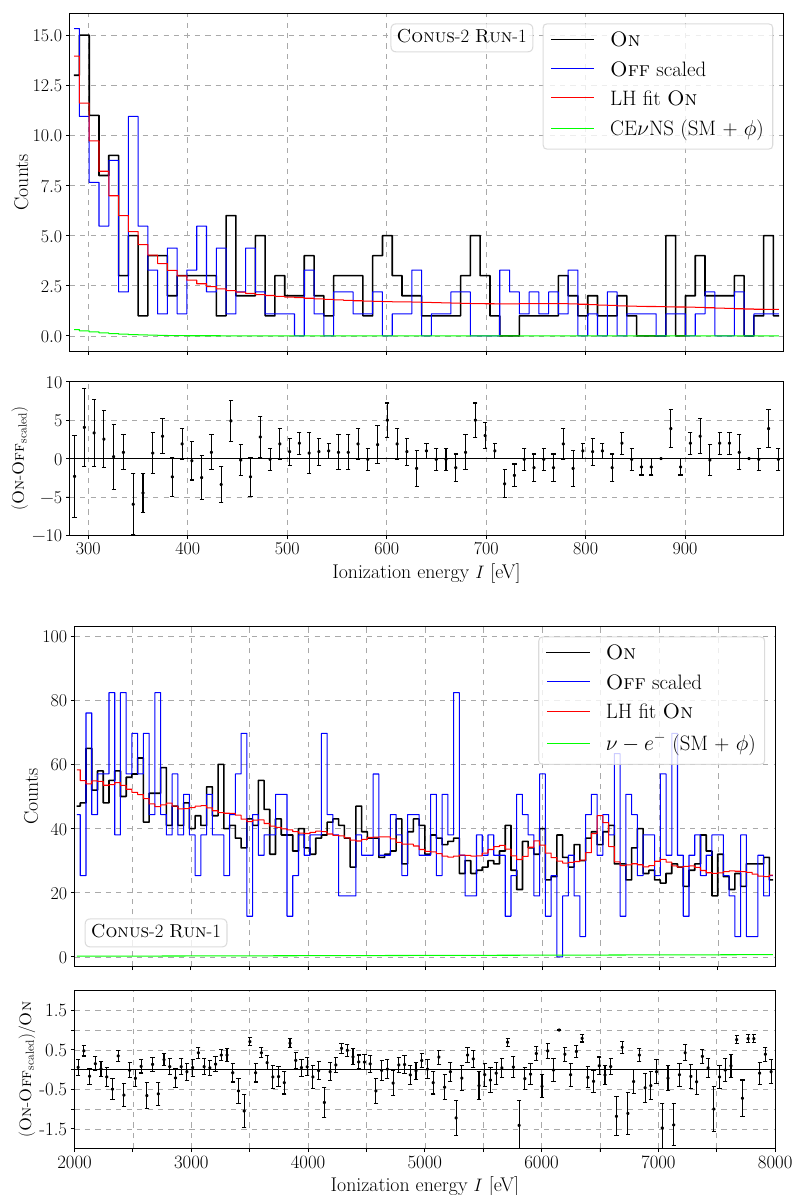
Figure 2 . Exemplary fits to experimental data in the case of a simplified light scalar mediator, cf. section 3.2.2. A combined fit to all data sets of table 2 is performed and collected reactor On data (black), the scaled reactor Off data (blue) as well as the obtained likelihood fit (red) are illustrated for detector C2 and a quenching parameter of k = 0 . 16 , assuming free coupling and mediator mass of the underlying BSM model. The received signal events (SM + BSM contribution) are indicated in green. Top: fit of the modified CE ν NS signal in the ROI below 1 keV ee . To illustrate the agreement between the collected reactor On and reactor Off periods, we show the corresponding residuals in total events beneath. Bottom: fit of modified neutrino-electron scattering in the ROI between 2 and 8 keV ee . To quantify the agreement of reactor Off data with the collected On data, residuals are given again (here normalized to the collected On